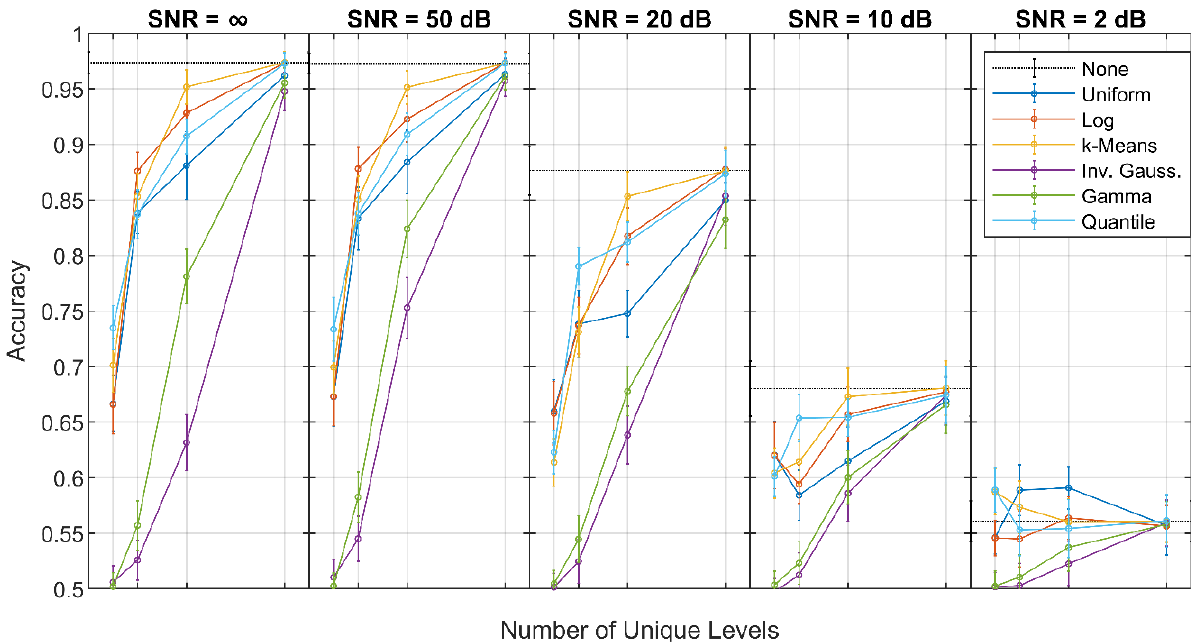
Figure 9. Accuracy of the quantizer scales for infinite, 50, 20, 10, and 2 dB SNR.